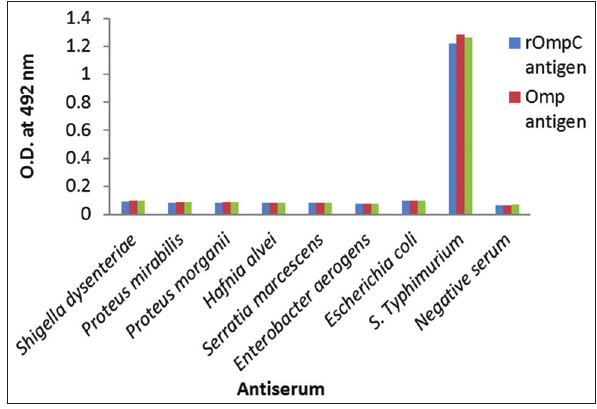
Figure-2: Cross-reactivity studies with various Gram- positive and negative